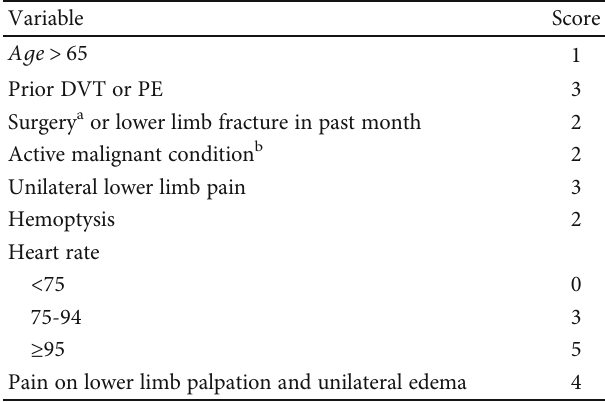
Table 2: Revised Geneva